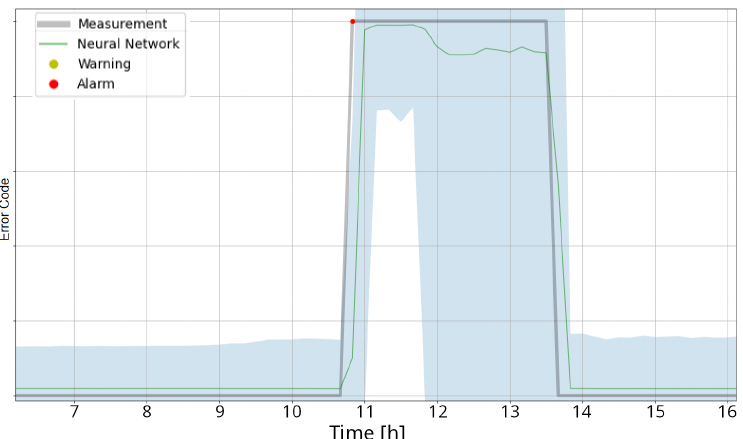
Figure 10. Sometimes the model can even predict the gearbox failure one time step too late. This can be seen in the shown instance there the error code appears 10 min before the DNN predicted likelihood for an error code goes